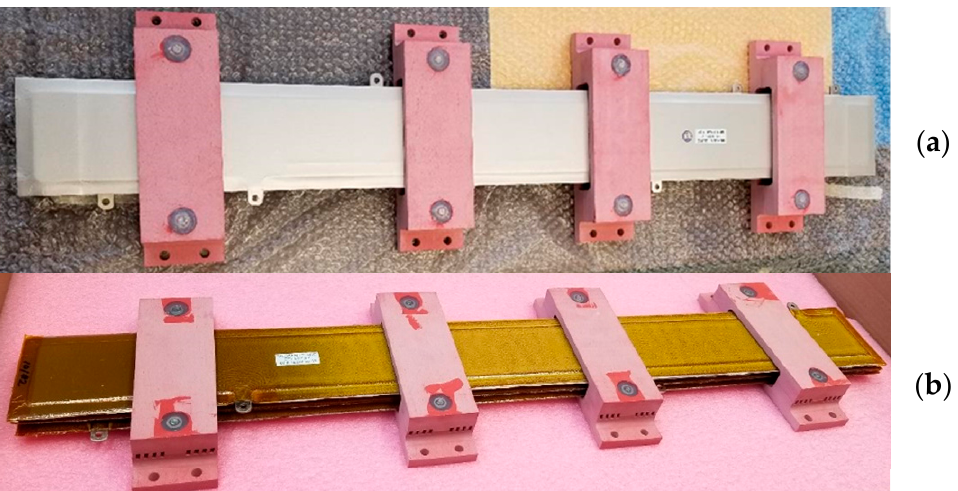
Figure 6. Full-scale 1 m long, 3-phase bus bar prototypes manufactured with the ( a ) with manufac- turer’s SOA insulation and ( b ) MMEI system targeting 10 MW at 20 kV. A reduction in the average insulation weight ( − 15%) and thickness ( − 12%) was seen for the NASA MMEI prototype compared to the manufactured bus bar.